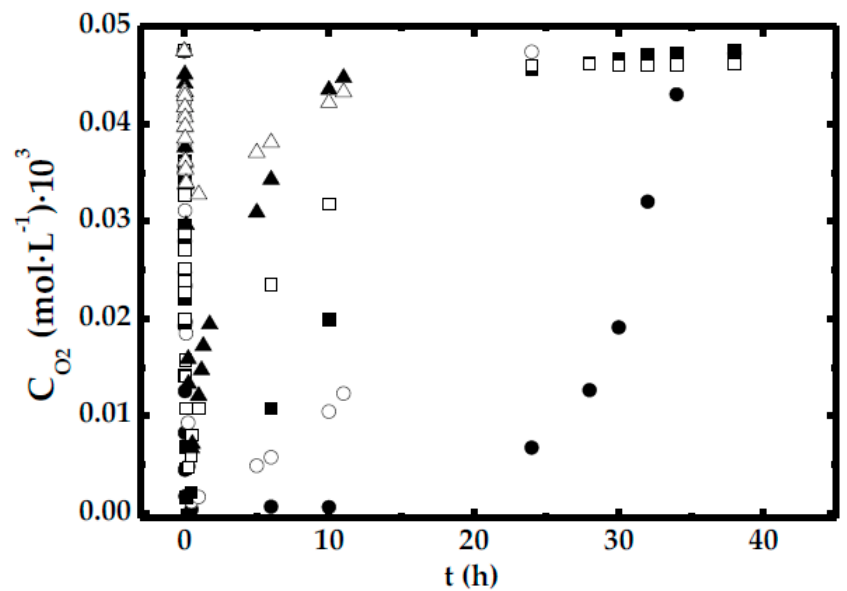
Figure 9. Experimental variation of dissolved oxygen (DO) concentration vs. time for runs 19 to 24 carried out in STBR employing different stirring speeds: 300 ( ● ), 360 ( ○ ) 420 ( ■ ), 560 ( □ ), 650 ( ▲ ), and 750 rpm ( ∆ ).